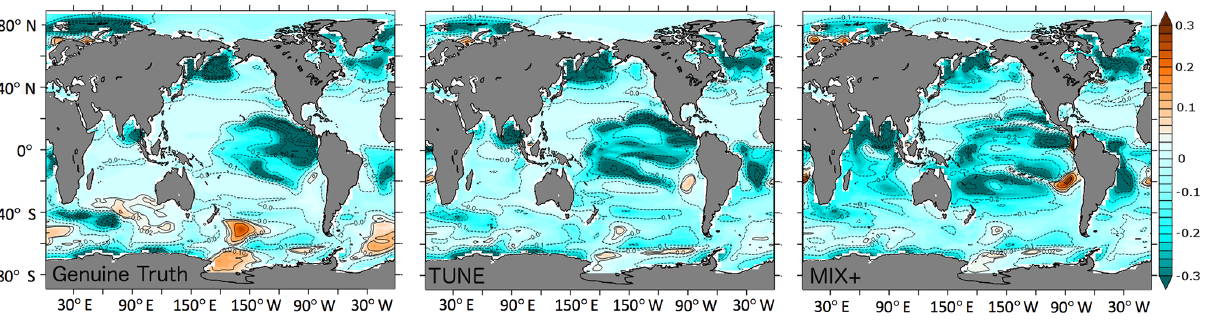
Figure 10. Simulated changes in surface phosphate concentrations as a consequence of rising CO 2 concentrations (emission scenario RCP8.5) calculated as the annual mean concentration difference between the years 2100 and 1850 (mmolPm − 3